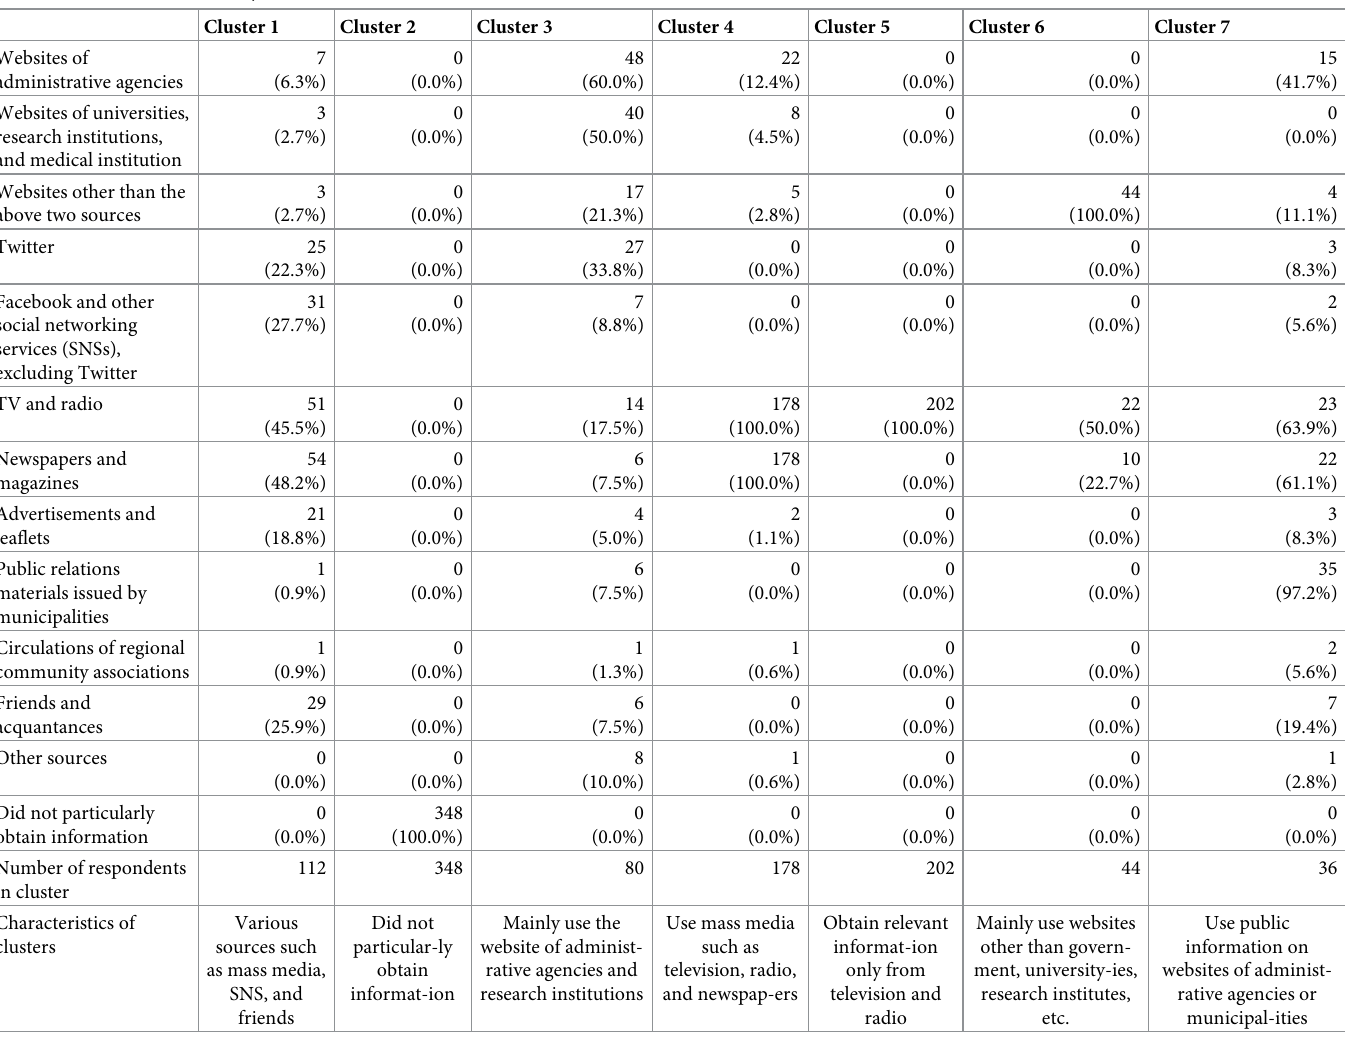
Table 4. Results of cluster